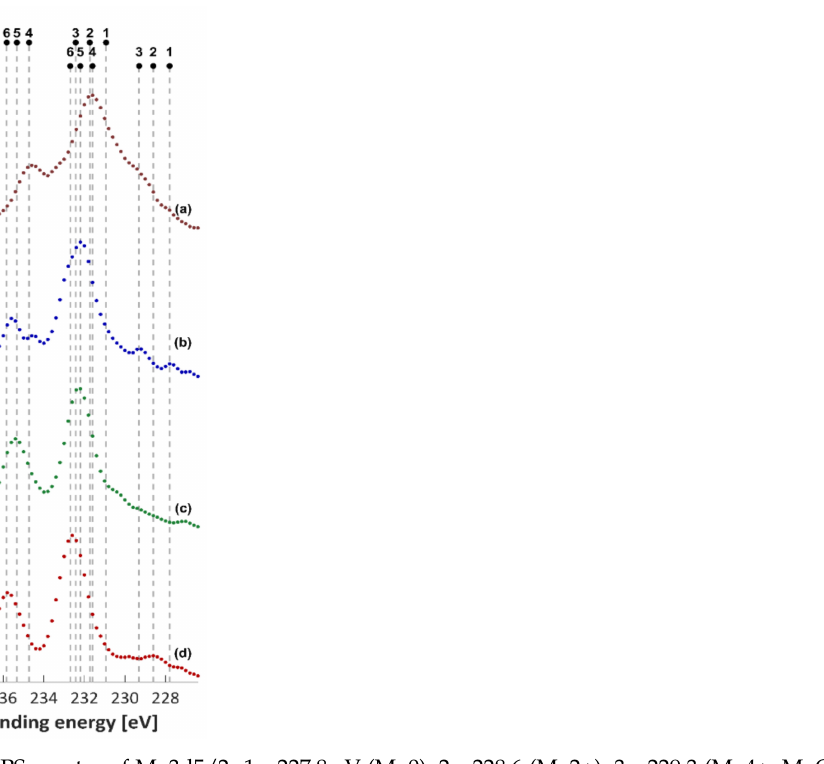
Figure 19. XPS spectra of Mo3d5/2: 1—227.8 eV (Mo0), 2—228.6 (Mo2+), 3—229.3 (Mo4+, MoO2), 4—231.6 eV (Mo5+; MoO3), 5—232.2 eV (Mo6+), 6—232.7 eV (Mo6+; MoO3). ( a ) Ti + 10 wt %(Ti,Mo)C, ( b ) Ti + 10 wt %(Ti,Mo)C/C, ( c ) Ti + 20 wt %(Ti,Mo)C, ( d ) Ti + 20 wt